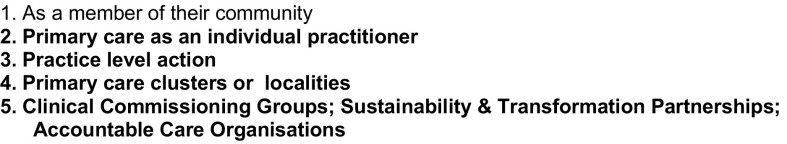
Levels at which primary care can take action [1,9,10].